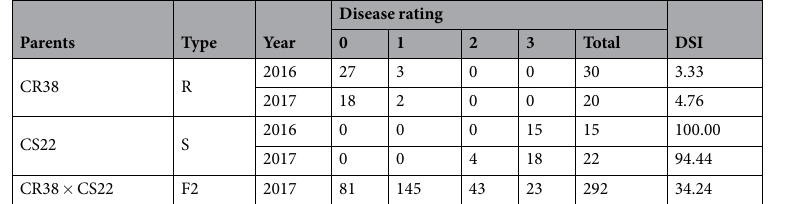
Table 1. Disease evaluations of CR in CR38 × CS22. = × ∑ ×